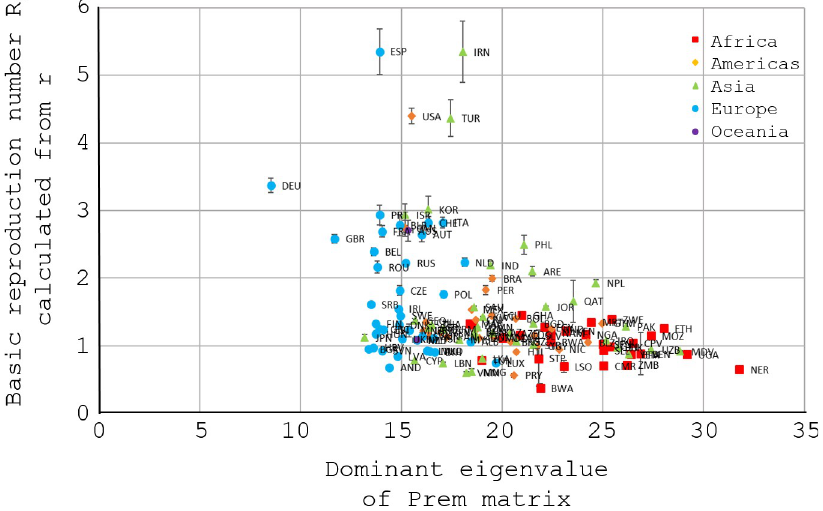
Fig 5. R 0 from Fig 4 vs the dominant eigenvalue C 0 of the Prem contact matrix. Fig 5 plots R 0 from Eq (2) with error against the basic contact rate, the dominant (largest non-negative) eigenvalue C 0 of the Prem matrix [20].